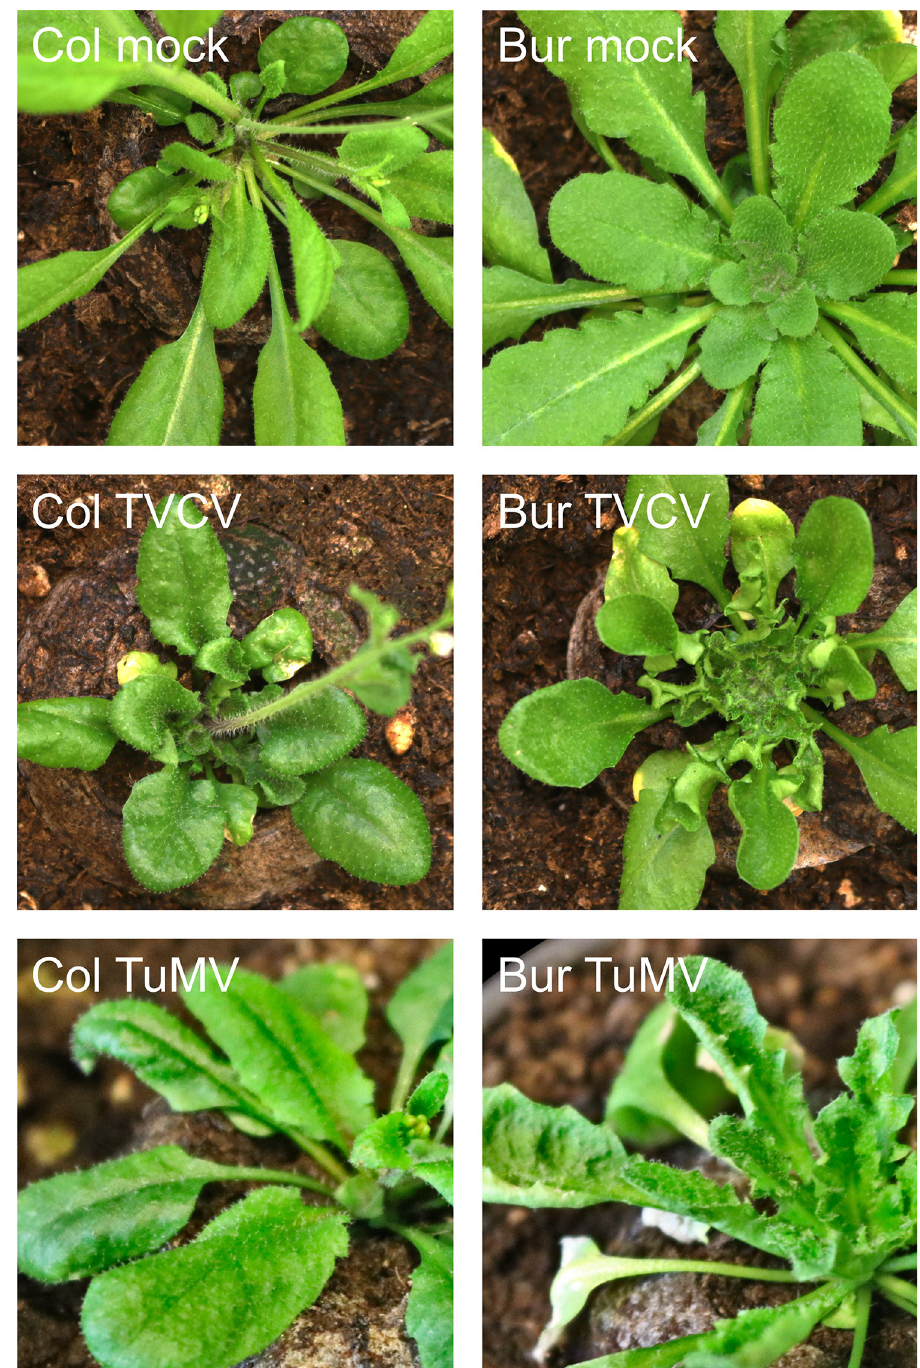
Fig 1. Viral symptoms of TVCV- and TuMV-infected Arabidopsis thaliana Col and Bur ecotypes. Four-week-old plants grown under long-day conditions at 21˚C were infected either with virus or mock solutions. After two weeks, plants were photographed and samples for RNA purifications were collected from mock- and virus-infected plants. For the RNA purification, samples were taken from symptomatic leaves of Bur or leaves of similar developmental stages from the Col and mock samples. To obtain one replicate, seven leaves from different plants were pooled (one leaf per plant). Four replicates were prepared in such a way for every mock and virus-infected sample.